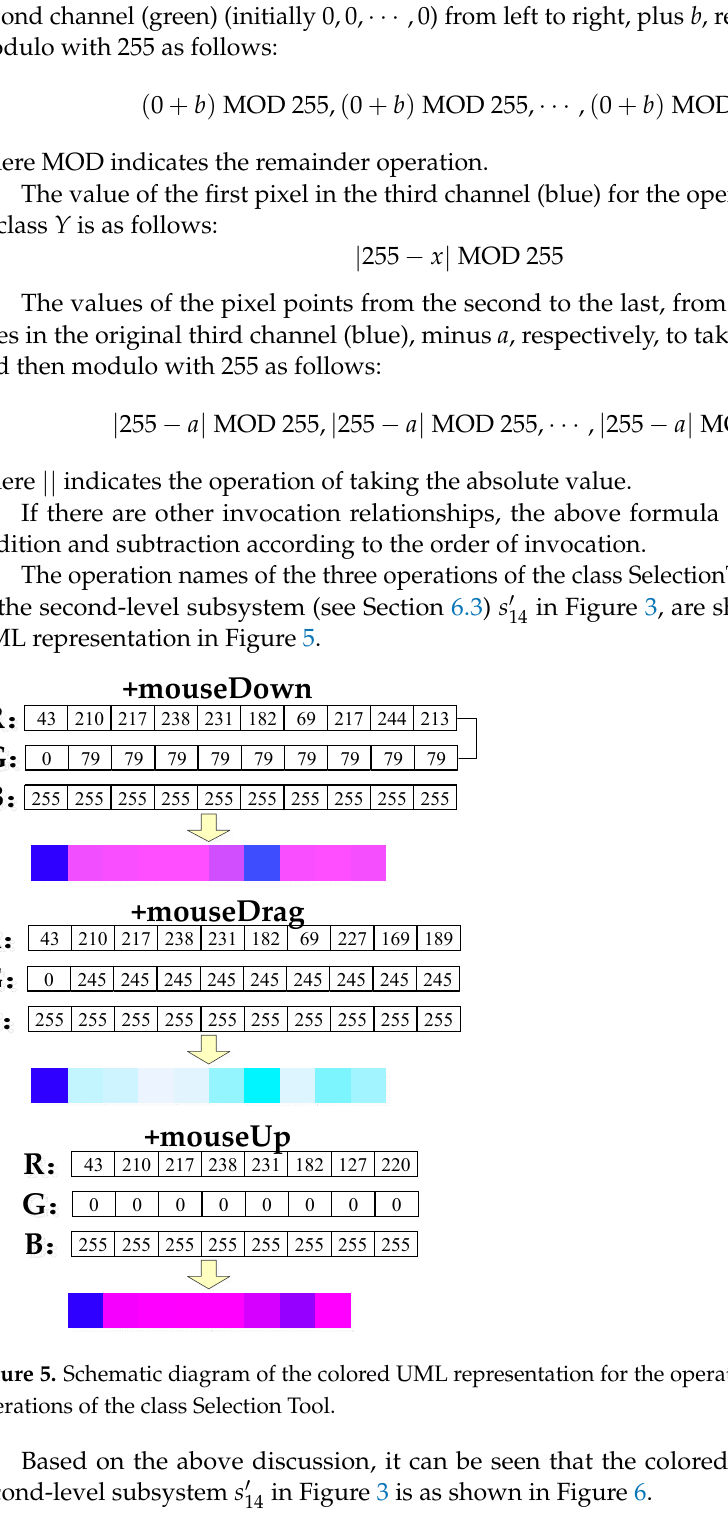
Figure 6. Second-level subsystem 14 s ′ represented by colored UML model. 4. Construction of the Sample Set After extending graph information for the traditional UML, it is needed to construct a high-quality (balanced positive and negative samples, low ratios of null and missing